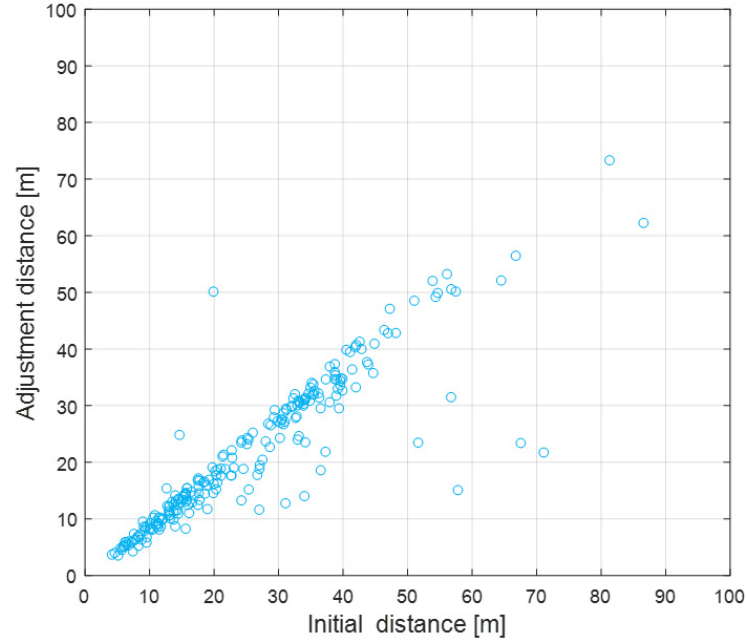
Figure 6. Correlation of initial distance and adjustment